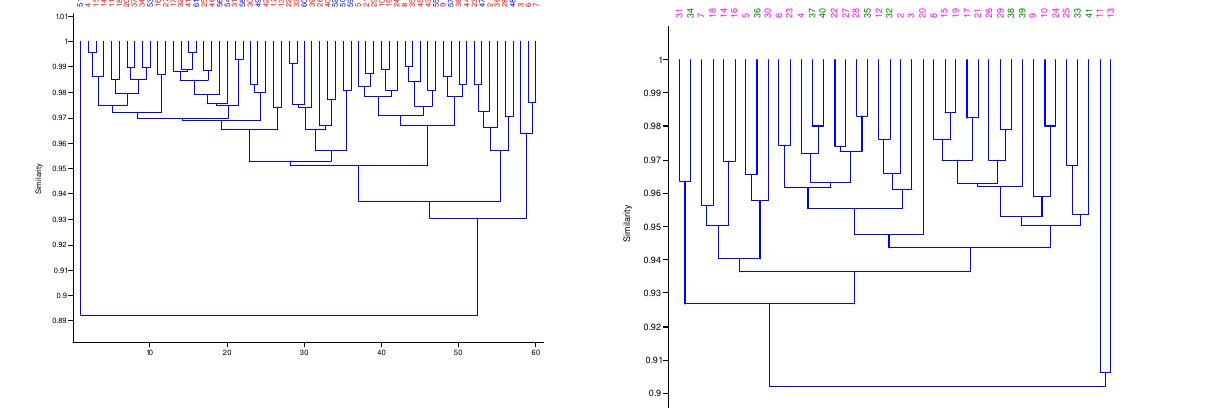
Fig. 11. Dendrogram showing similarity coefficient (89.2%) of the meristics of right side of wild Clarias gariepinus employing the Bray-Curtis’s clustering algorithm *Red color indicates male, blue color indicates female